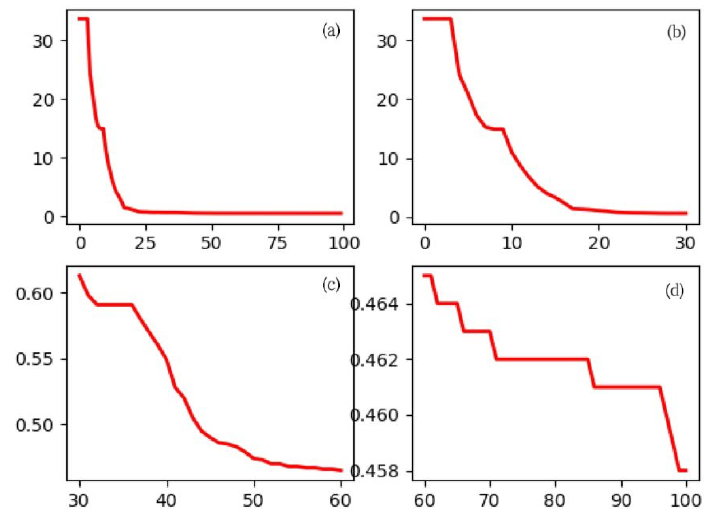
Figure 7. Training error (x-axis: Iteration; y-axis: MSE